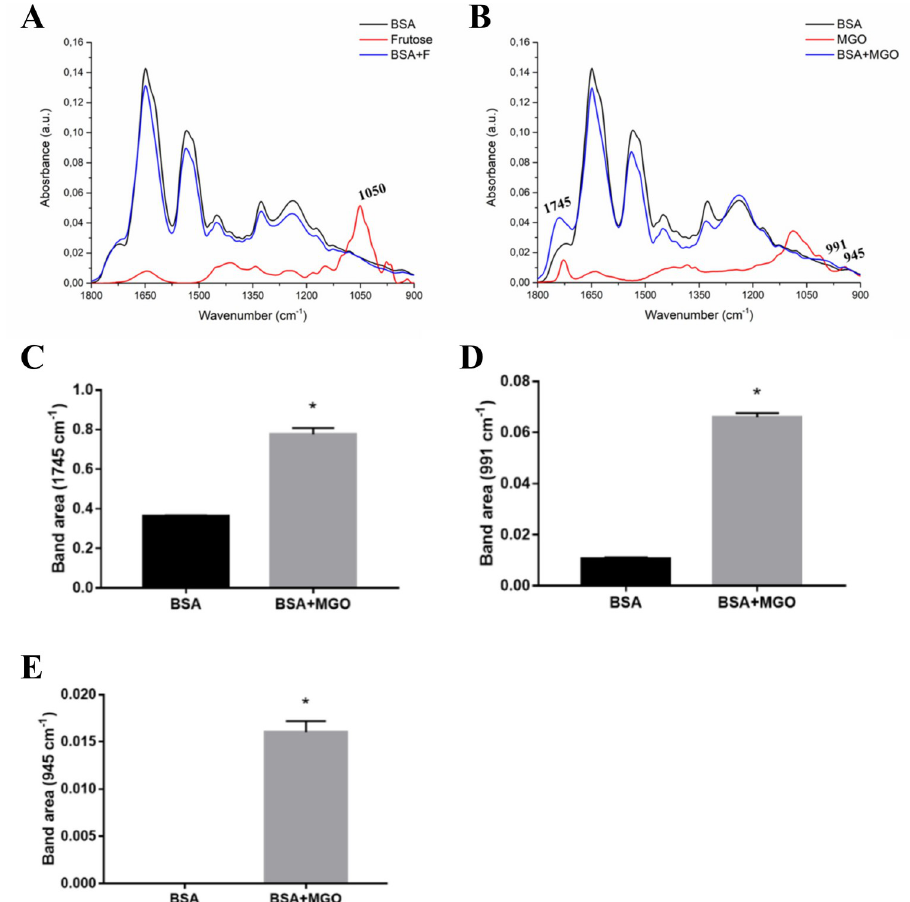
Fig 2. Average ATR-FTIR spectra (1800–900 cm -1 ) of BSA, fructose, MGO, and BSA incubated with these glycating agents. (A) BSA and BSA with fructose (BSA+F). (B) BSA and BSA with MGO (BSA+MGO). Peak area of the spectra in vibrational modes in 1745 cm -1 (C), 991 cm -1 (D) and 945 cm -1